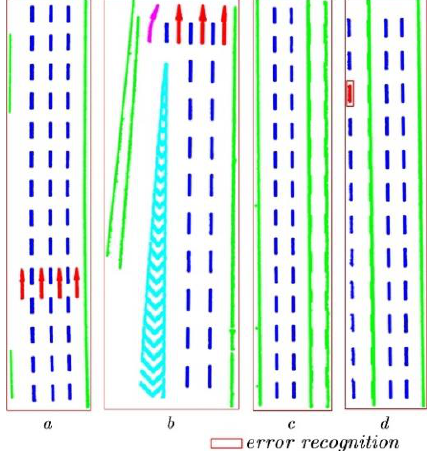
Figure 17. Semantic recognition result of each cluster